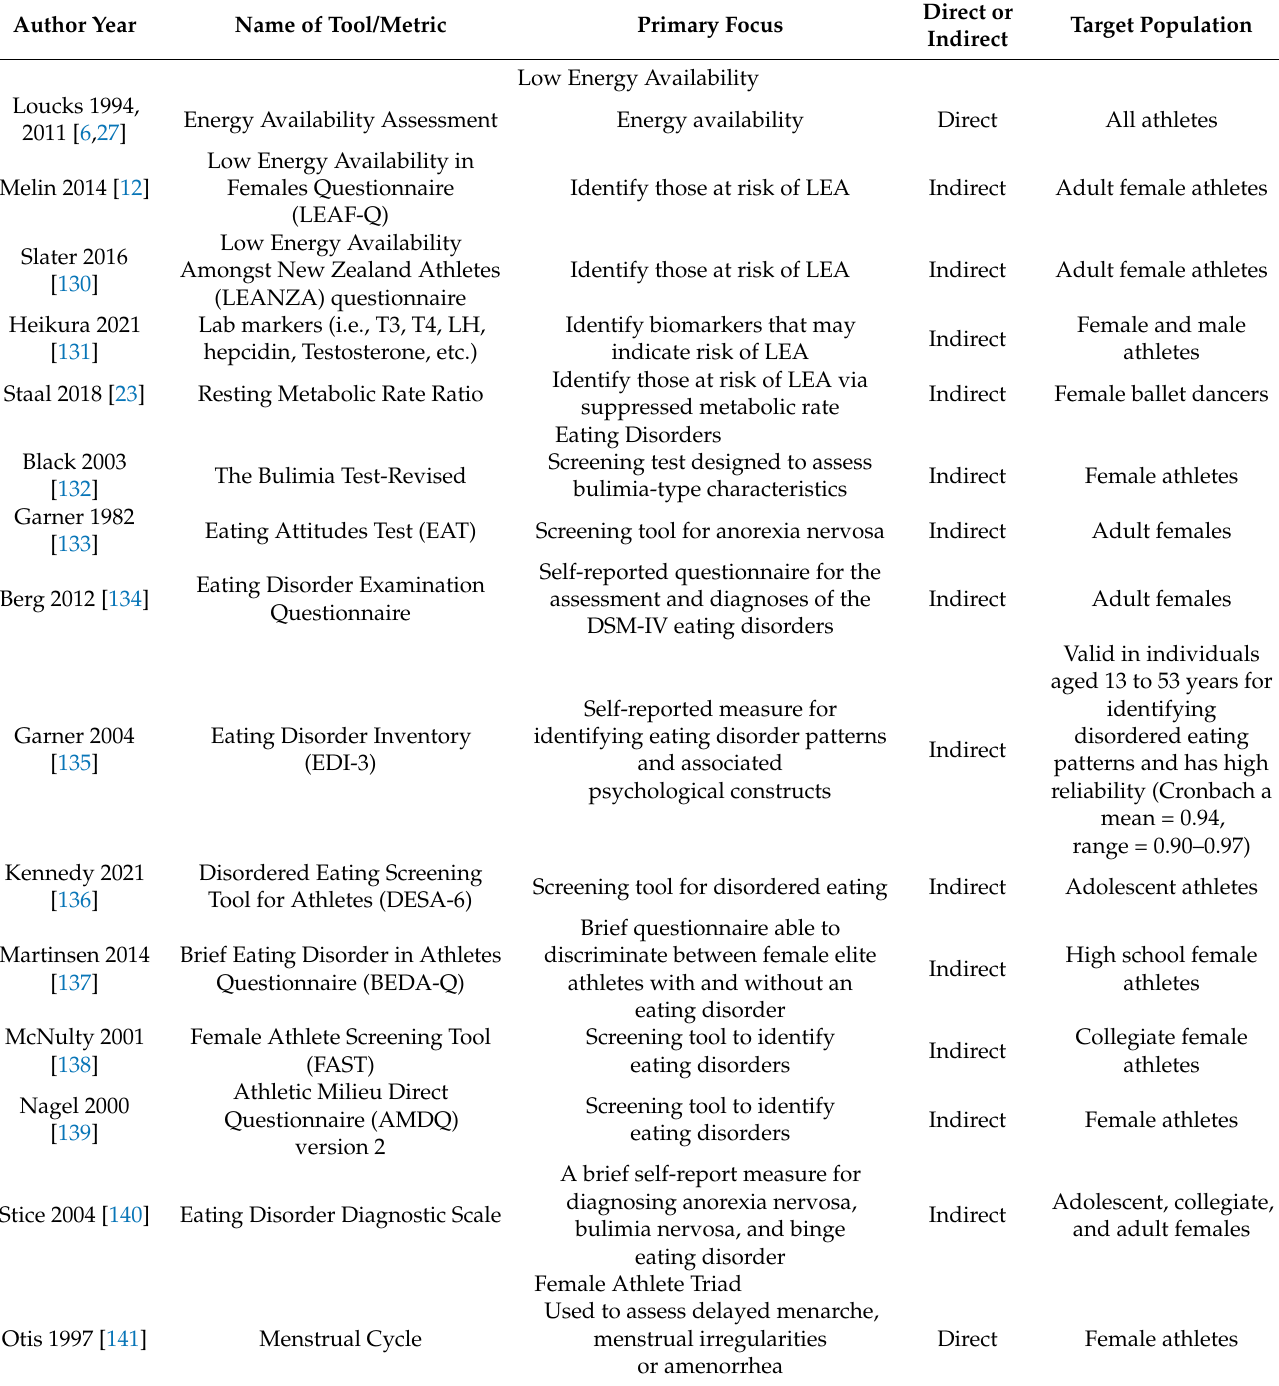
Table 4. A summary of validated screening tools used to identify those at risk for low energy availability, eating disorders, female athlete triad, or body